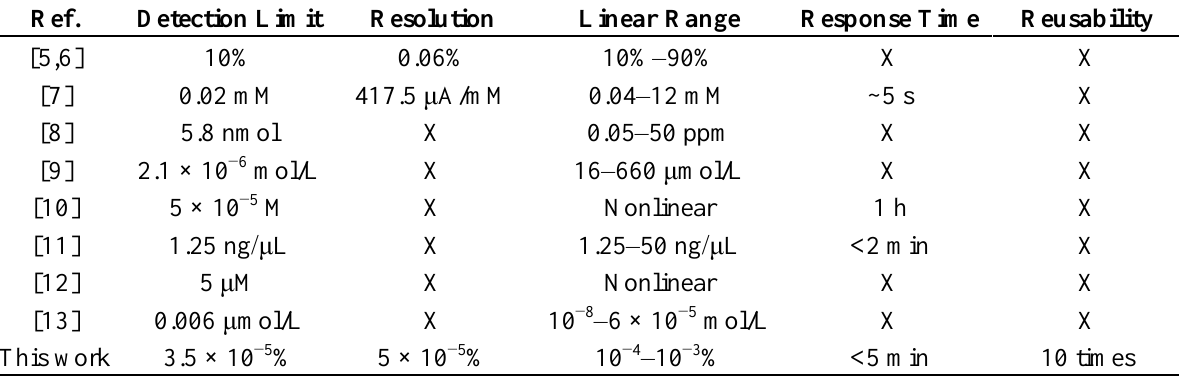
Table 3. Performance of different H 2 O 2 concentration measurement